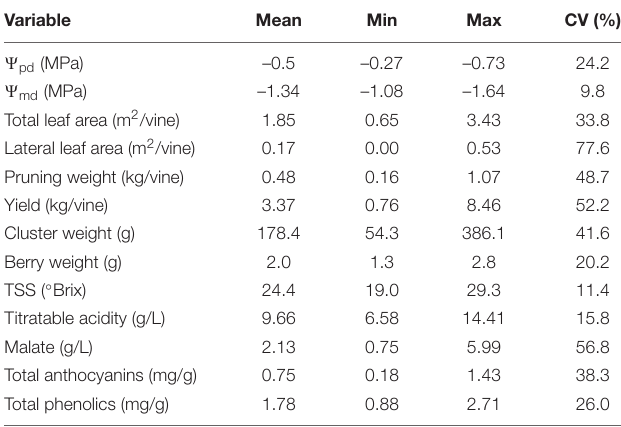
TABLE 2 | Mean, minimum and maximum values, and coefficient of variation (CV%) for leaf water status, canopy growth, yield components, and fruit composition of Barbera grapevines recorded in